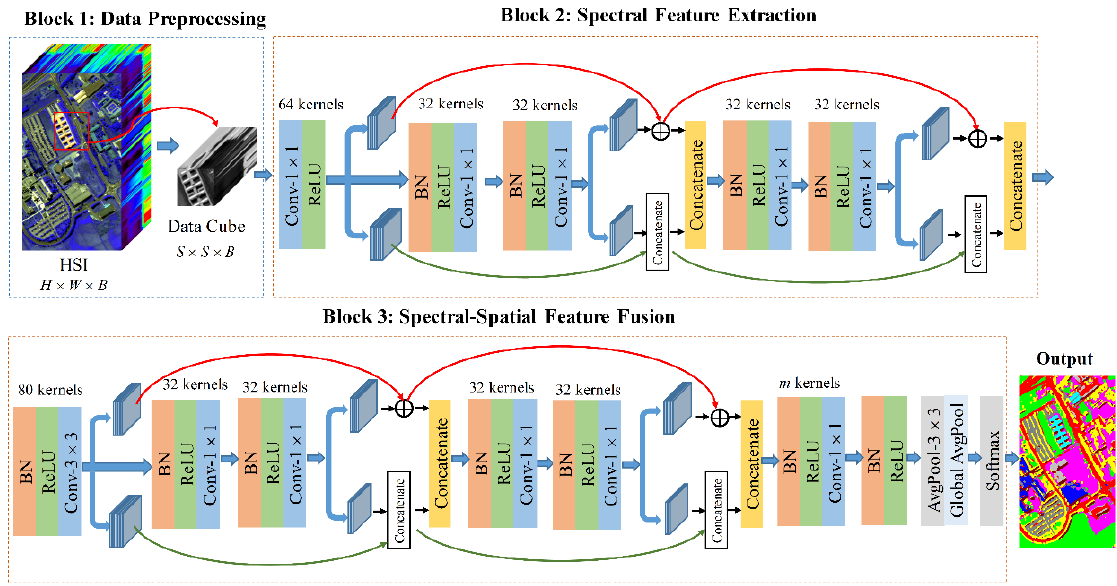
Figure 3. The integral structure of the dual-path small convolution network (DPSCN).